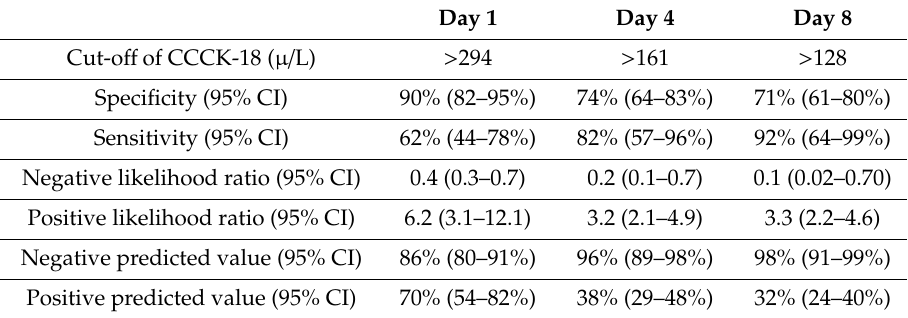
Table 2. Receiver operation characteristic analysis using serum caspase-cleaved cytokeratin (CCCK)-18 levels on day 1, day 4, and day 8 after trauma brain injury as predictor of mortality at 30 days.